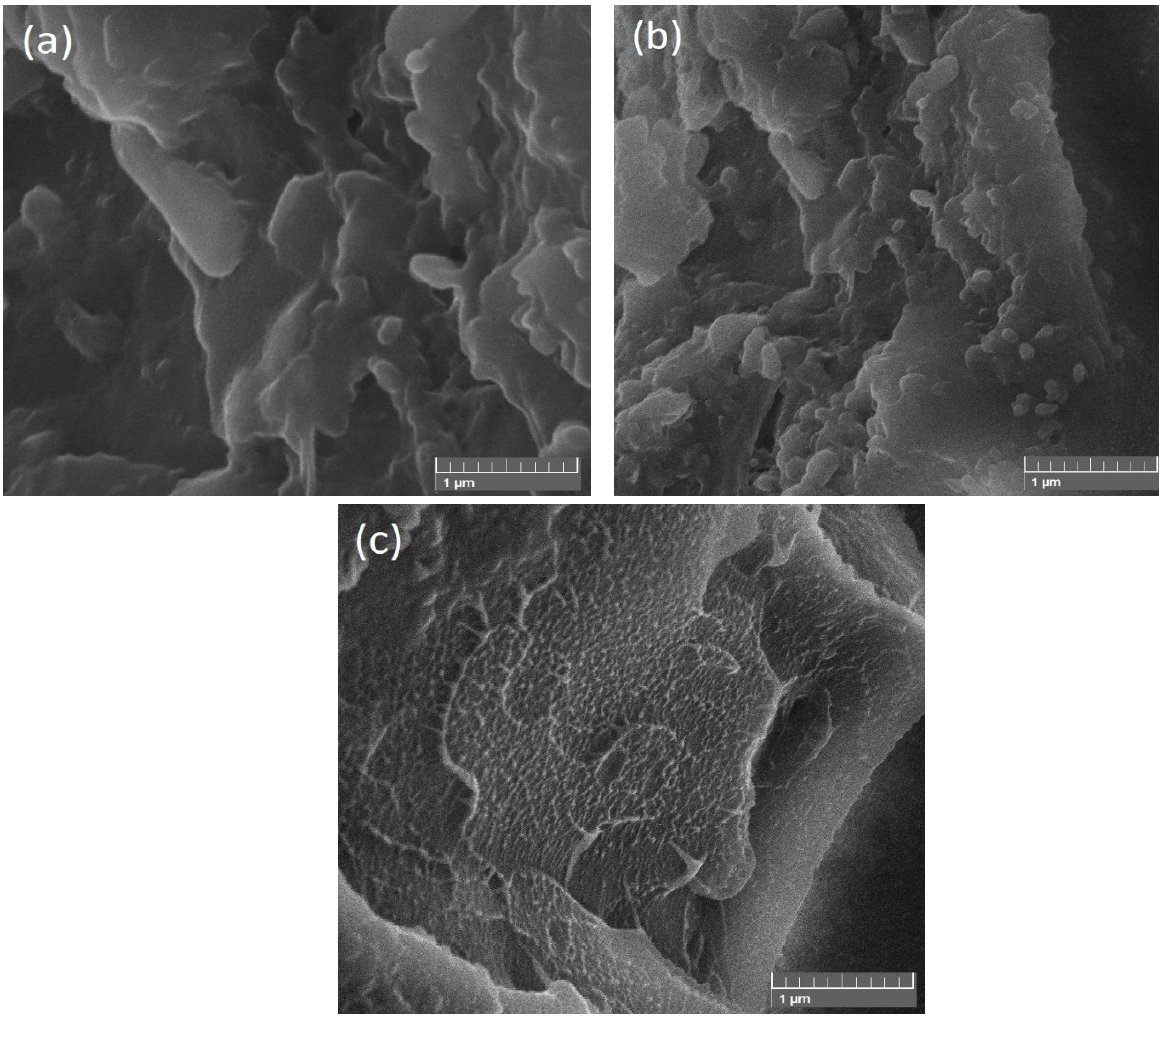
Figure 4. SEM Images of ( a ) S1, ( b ) S2, and ( c ) S4.